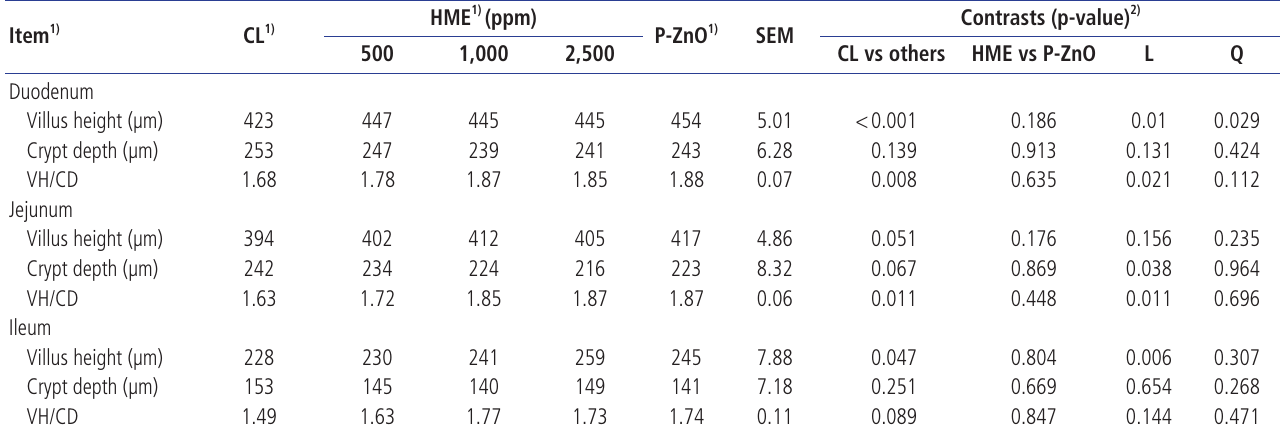
Table 7. Effects of different ZnO sources on small intestinal morphology of weanling pigs (d 28) Item